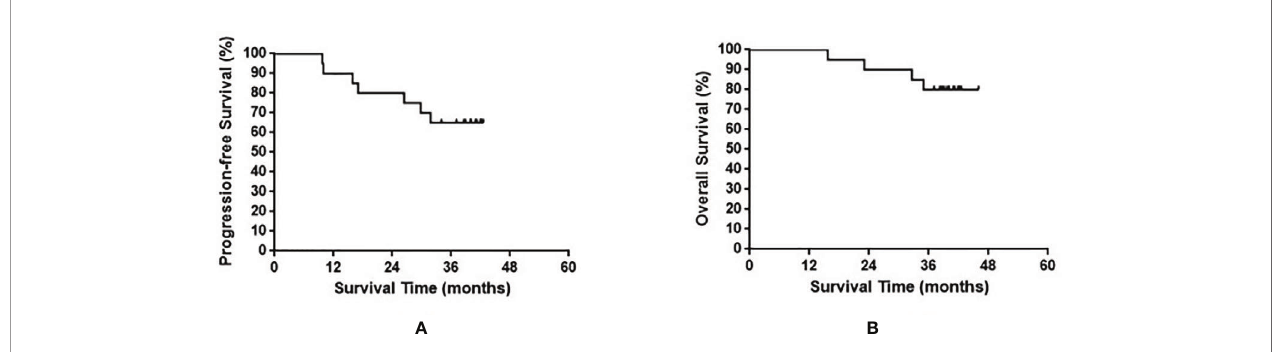
FIGURE 1 | Progression-free survival (A) and overall survival (B) in all small cell lung cancer patients enrolled in the present study.